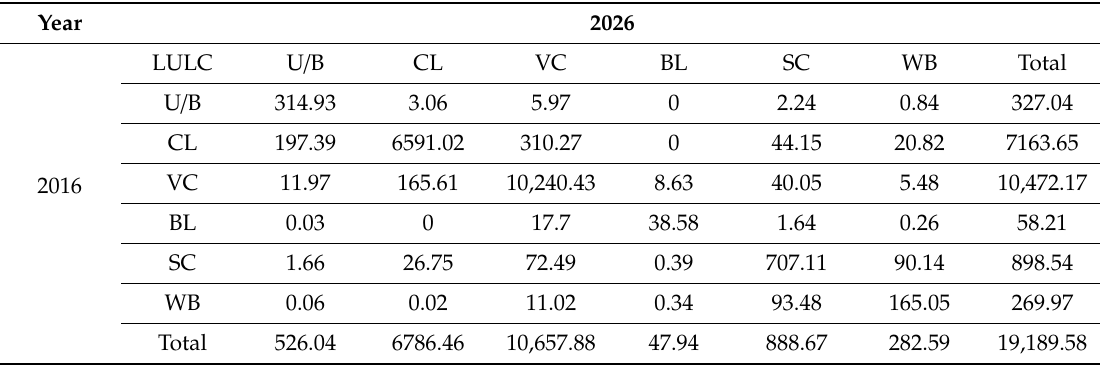
Table 4. LULC transitions during 2016–2026 (in km 2